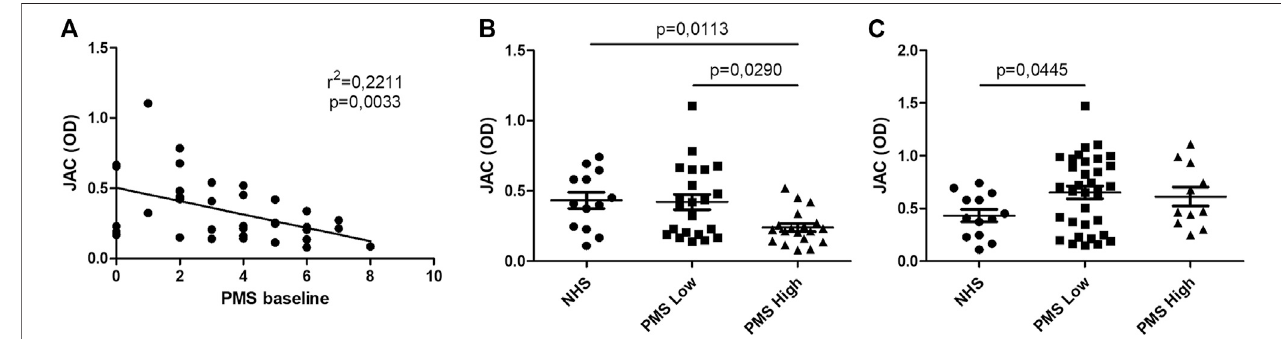
FIGURE 3 | JAC af fi nity for IgG complex in comparison with Partial Mayo Score (PMS). Lectin-based ELISA coated with Fab anti-IgG Fab. (A) : linear correlation between PMS and JAC af fi nity. (B, C) : JAC af fi nity for IgG complex in Ulcerative Colitis with Low PMS ( ≤ 5) and High PMS ( > 5) compared to healthy subjects (NHS), at baseline (B) and after anti-TNF therapy (C) . All values are expressed as Optical Density